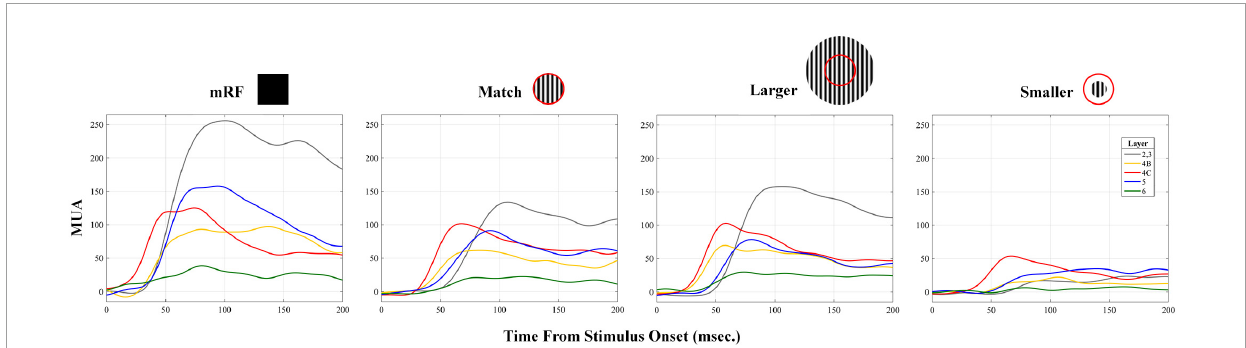
FIGURE10 Laminar average multiunit activity (MUA) in response to stimuli. An example of the MUA response averaged in response to all four types of stimuli is shown. The X-axis shows the time in milliseconds and the Y-axis represents MUA. The stimulus type is written at the top of each column. The number of layers is indicated at the top of the first column.